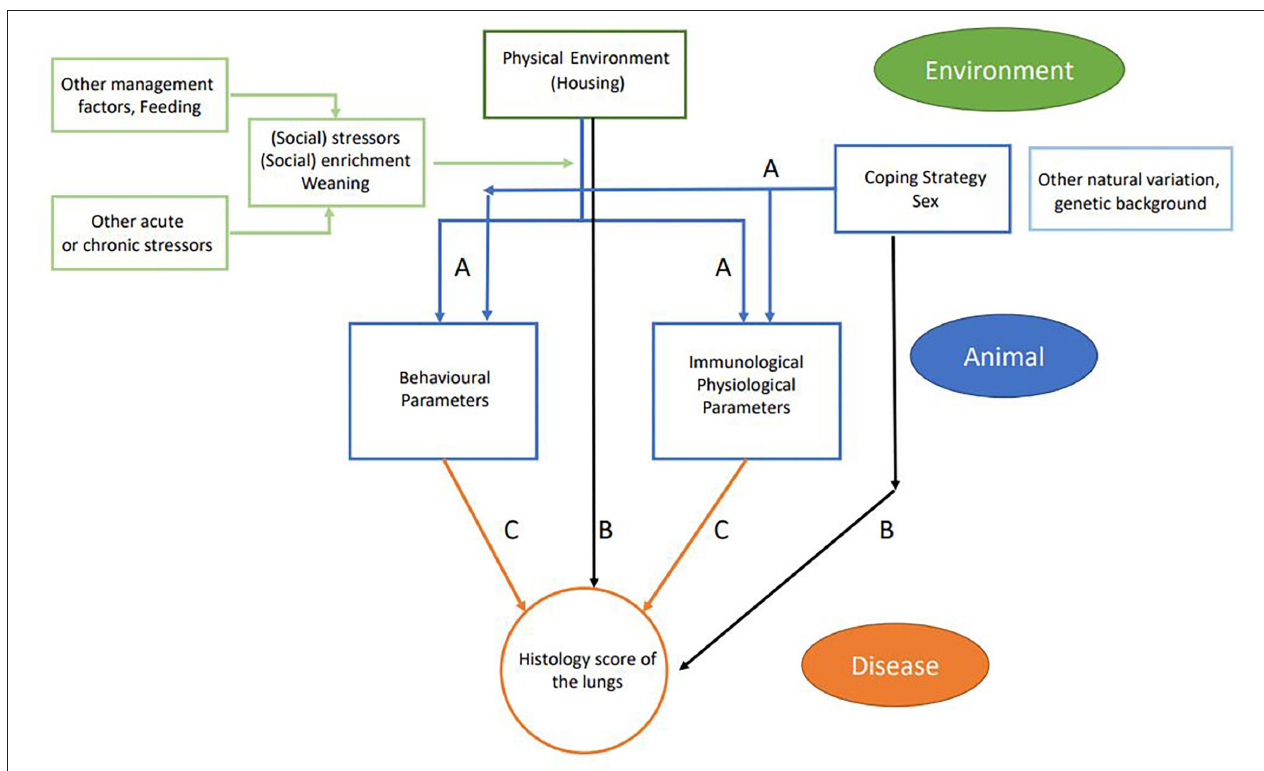
FIGURE 3 | Schematic flowchart of linkage between farm management practices (environment and management factors in green), animal-based measures (in blue), and disease outcome (in orange). Arrows indicate the different relations that were tested: blue arrows (A) relate to experimental variables (housing, coping, and sex) and explanatory variables; black arrows (B) relate to experimental variables (housing coping and sex) and disease outcome; and orange arrows (C) relate to explanatory variables and disease outcome including housing, coping, and interaction housing × explanatory